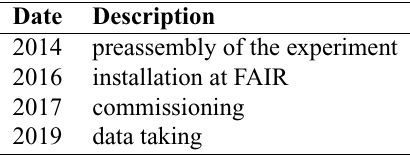
Table 1. Schedule with milestones of the PANDA